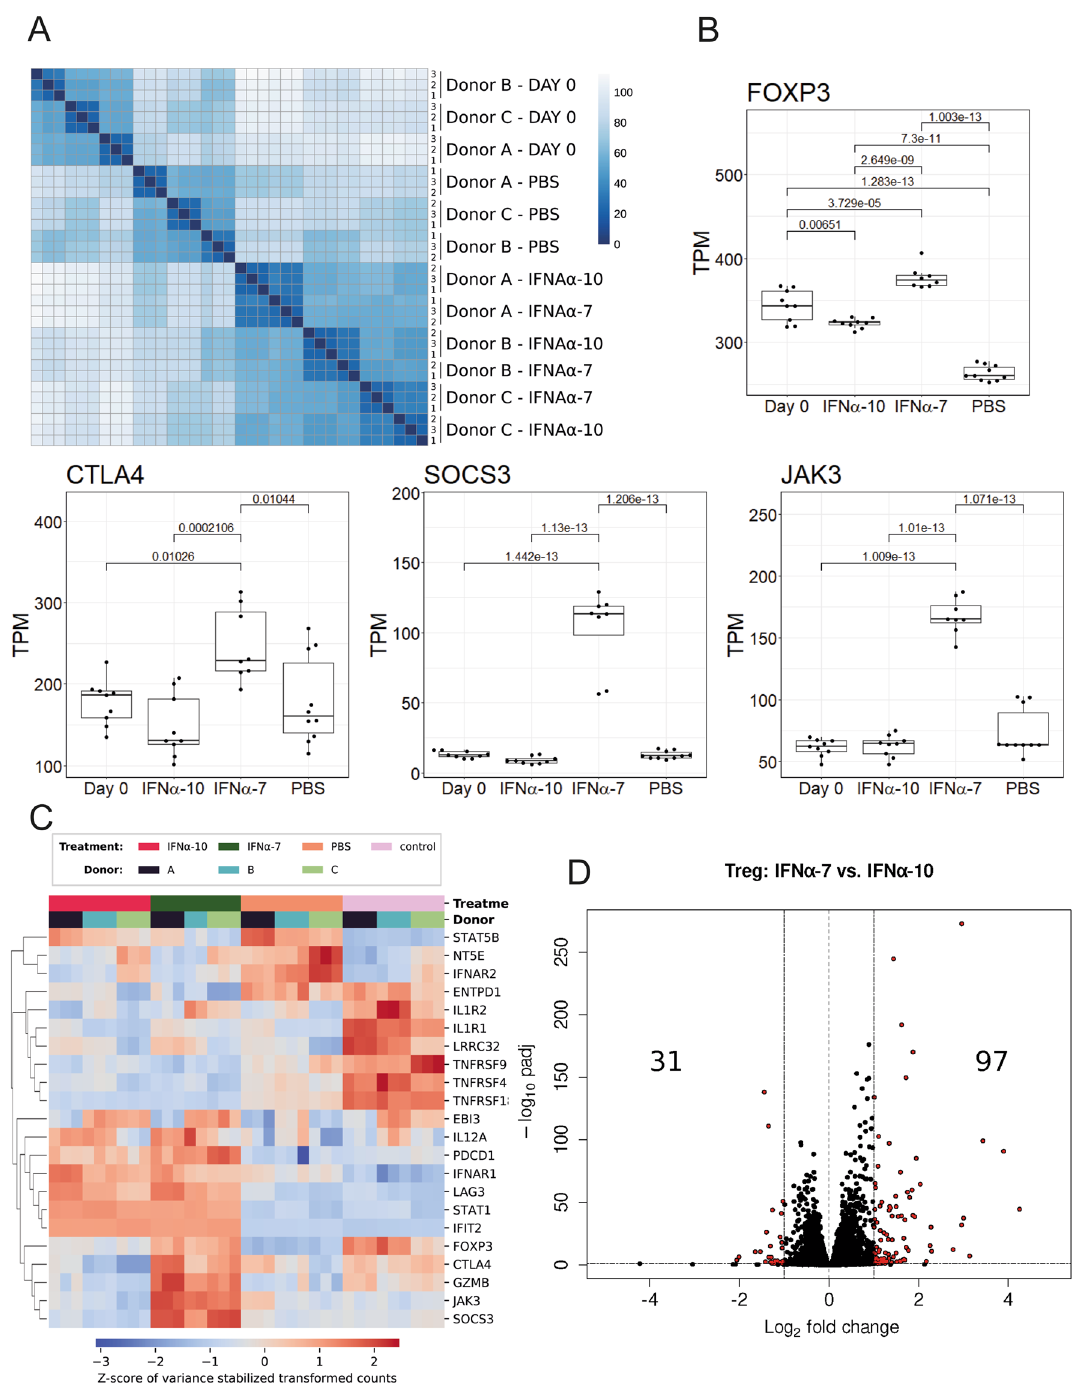
Figure 4. Transcriptomics reveal distinct activation profile for IFNα-7 compared to IFNα-10. ( A ) Heatmap of the sample-to-sample euclidean distances for the RNA samples, based on variance stabilised counts data. ( B ) Expression analysis (TPM) shows that FOXP3, CTLA4, SOCS3 and JAK3 genes were upregulated when comparing IFNα-7 treated to IFNα-10 treated cells. ( C ) Heatmap showing differences in expression between samples for genes mentioned in the results section. Values were based on transformed count data (variance stabilising transformed) extracted from DESeq2 with its vst function and with blind set to FALSE. Z-scores were subsequently applied to accentuate differences between samples. ( D ) Differentially expressed genes (twofold change and FDR < 0.05) when comparing IFNα-7 and IFNα-10 treatments of Treg cells; 97 genes were significantly upregulated and 31 genes were downregulated with this threshold. Heatmap of the sample-to- sample euclidean distances for the RNA samples, based on variance stabilized counts data . Treg cells from 3 individual donors were analysed in the transcriptomics experiments in 3 replicates from each individual